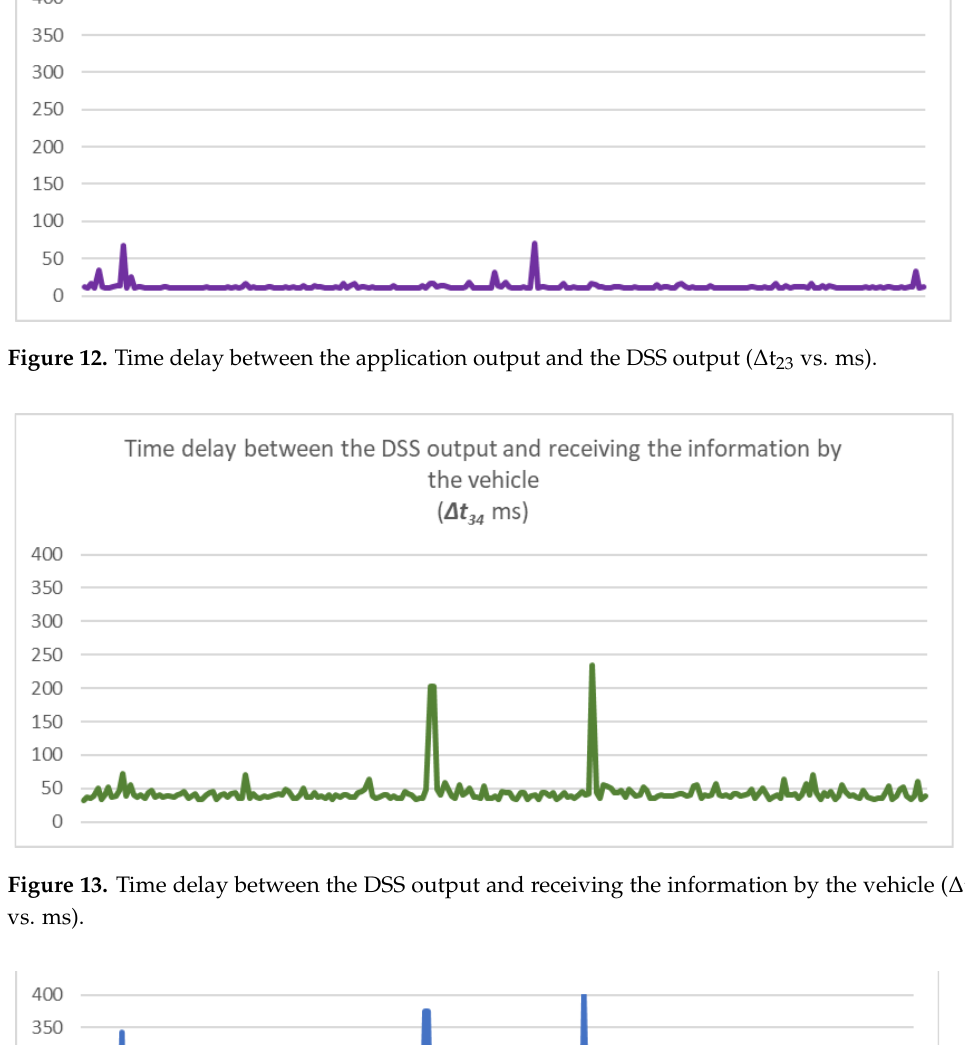
Figure 11. Time delay between detection and application exit (Δt12 vs . ms).